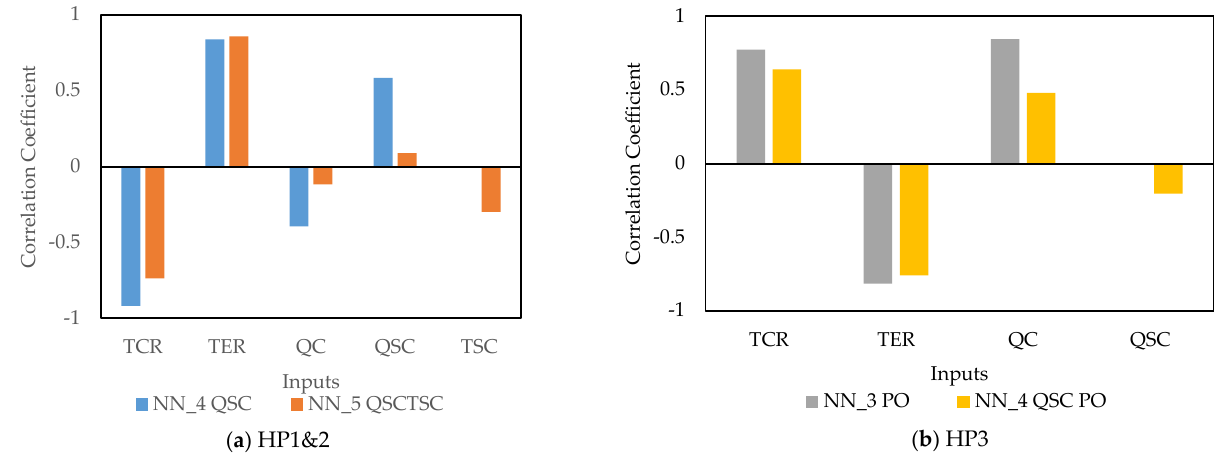
Figure 7. Partial correlation coefficients between the inputs and outputs of the selected models for ( a ) HP1&2; and ( b ) HP3.